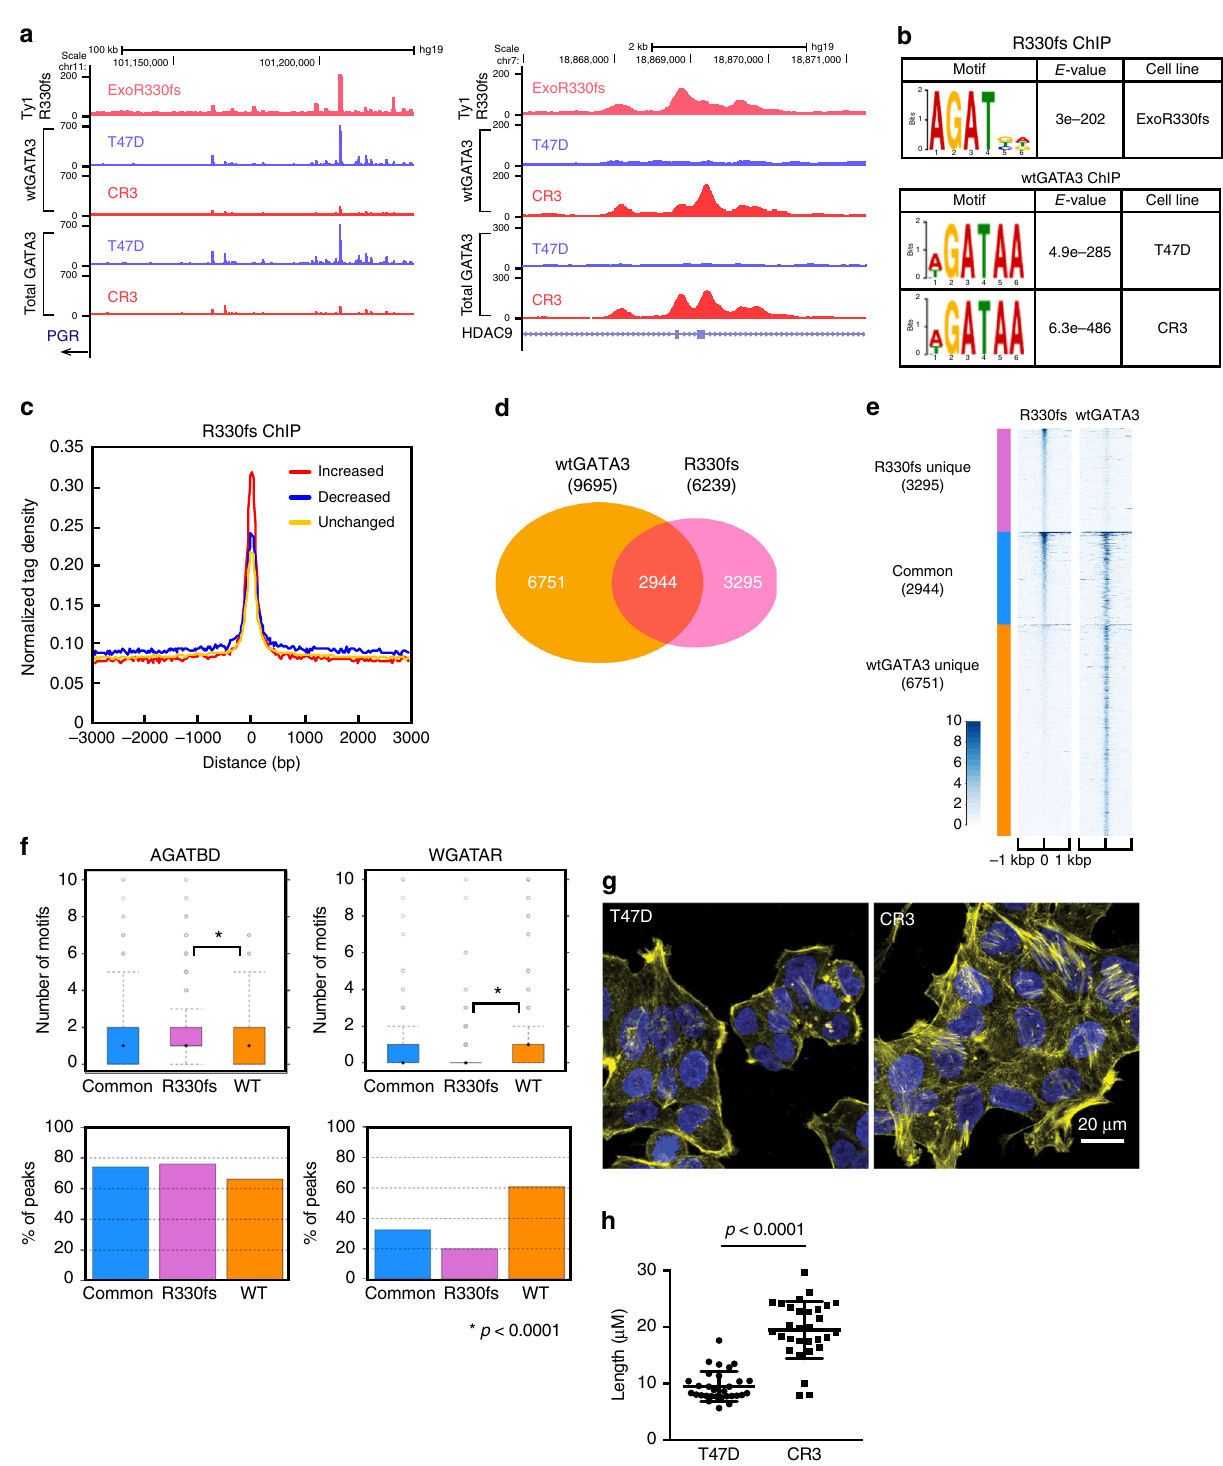
Fig. 5 Aberrant chromatin-binding property of R330fs mutant in fl uences GATA3 localization. a Representative genome browser tracks at R330fs-mutant- binding loci. UCSC Genome Browser views showing the mapped read coverage of R330fs mutant, wild-type GATA3, and total GATA3 ChIP-seq data. The read densities in T47D and CR3 cells are presented in blue and red, respectively. b Top-ranked motif at R330fs and wild-type GATA3-binding sites. The motif was identi fi ed by MEME. c Metaplot pro fi les of normalized R330fs mutant ChIP-seq signals. The normalized signals in each GATA3-peak group were plotted. d Venn diagram showing the overlap between wild-type GATA3 peaks in CR3 (red) and R330fs mutant peaks (yellow). e Read density heatmap showing the ChIP-seq signals of R330fs mutant and wild-type GATA3 in each peak category (de fi ned by peak overlap analysis shown in d ). f Consensus and non-consensus GATA3-binding motifs. The box plots showing the number of motifs/peak in each peak group (R330fs-WT common, R330fs unique, WT unique). The bar graphs showing the frequency of peaks that contain the AGATBD motif or WGATAR motif. g Immunostaining of F-actin by phalloidin as observed by confocal laser scanning microscopy. Green: F-actin; blue: DAPI. h Quantitative analysis of actin fi lament formation shown in g . The length of actin fi bers was measured by ImageJ software. Mean and SD are indicated in the scatter dot